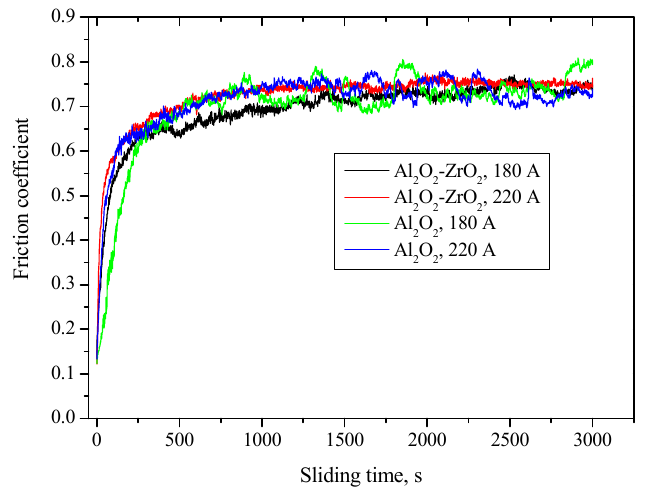
Figure 5. Friction coefficient curves of Al 2 O 3 and Al 2 O 3 -ZrO 2 coatings.